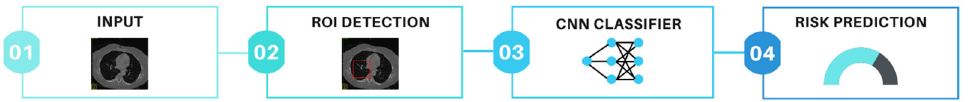
Figure 5. Example of an ‘end to end’ cancer detection pipeline. 1: A whole CT volume is used as input into the model. 2: A region detection architecture (such as UNet) is used to identify a sub-volume and assign a bounding-box ROI. 3: The volume encompassed by the ROI is input into a classification CNN (such as InceptionNet) to learn patterns associated with the outcome variable. 4: A risk prediction of malignancy is output. Abbreviations: ROI: region of interest, CNN: convolutional neural network. CT images taken from the public LUNGx dataset [97].